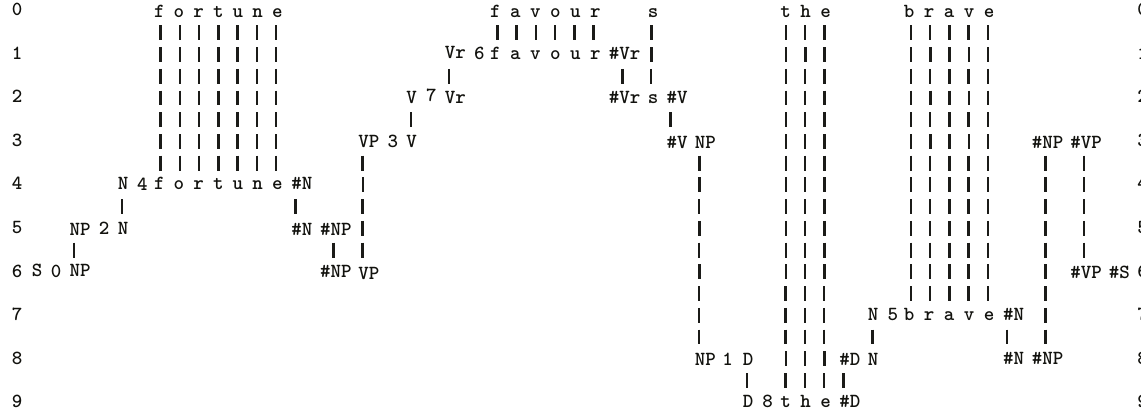
Figure 4: The best SP-multiple-alignment produced by the SP Computer Model with a New SP-pattern representing a sentence to be parsed and a repository of user-supplied Old SP-patterns representing grammatical categories, including words. Reproduced with permission from Figure 2 in